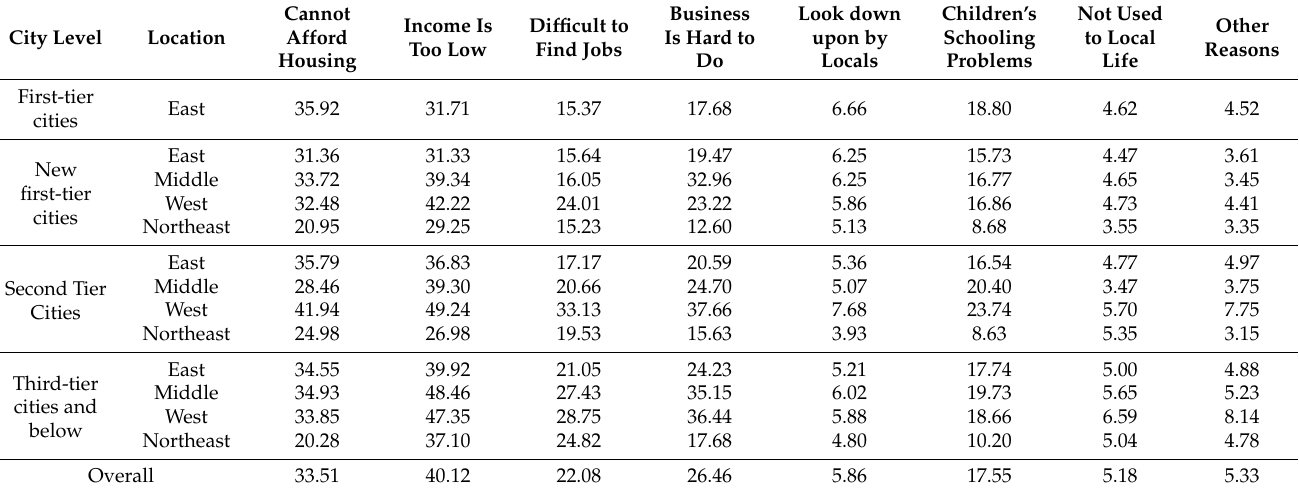
Table 6. Percentage of floating population’s difficulties in different regions and cities, 2017